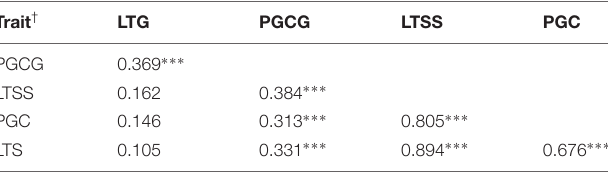
TABLE 2 | Pearson’s correlation coefficients between the five different rice seedling chilling tolerance indices evaluated in this